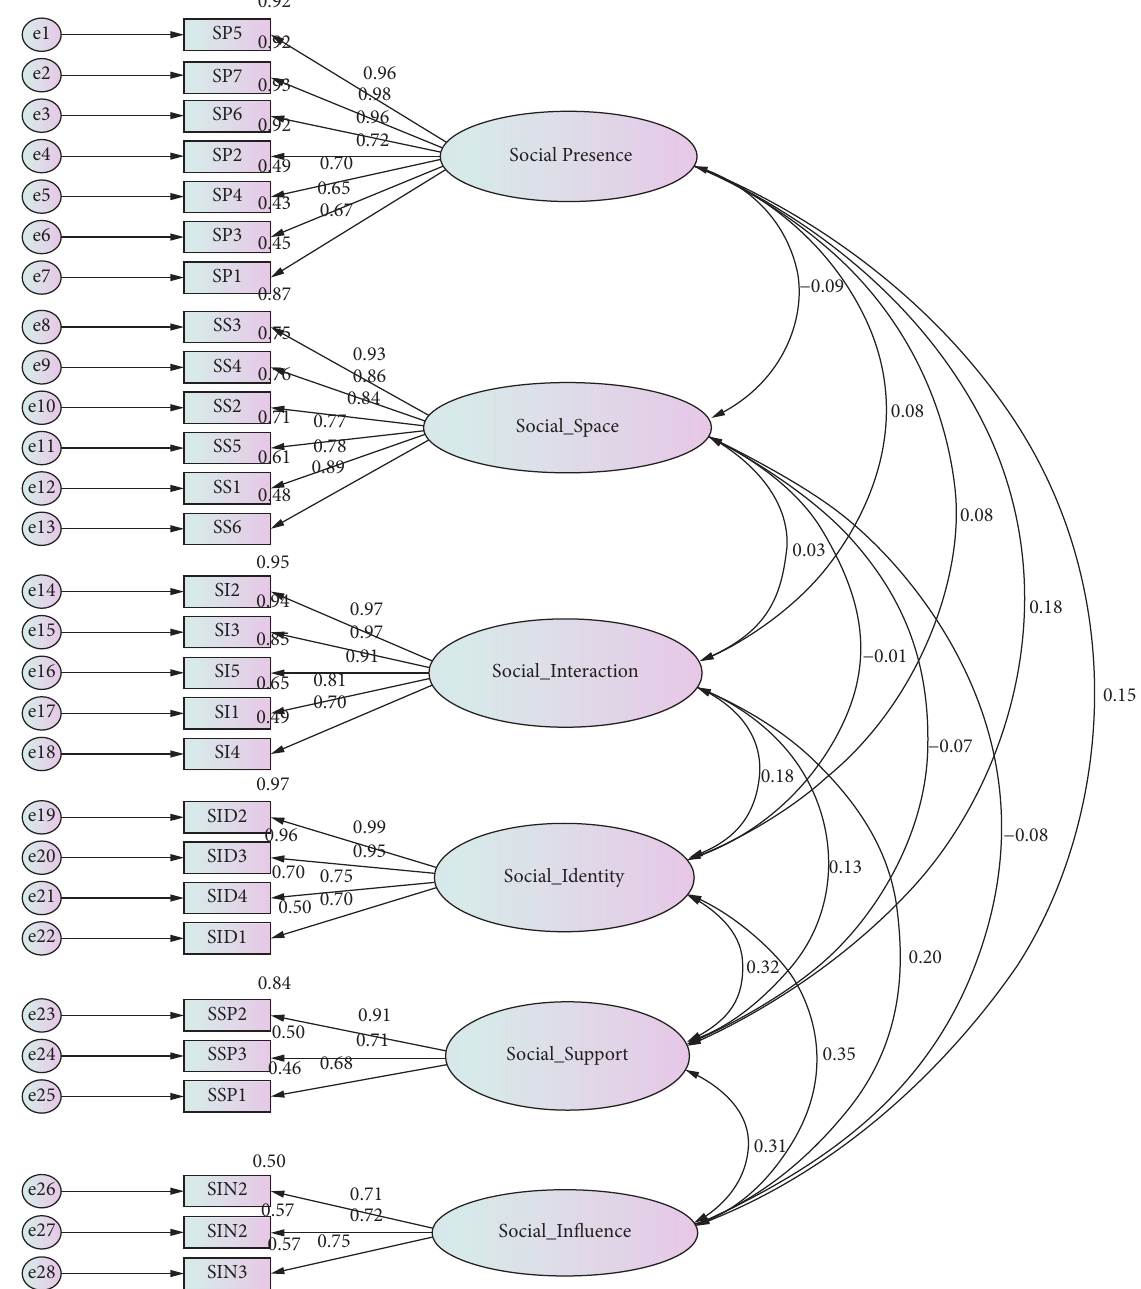
Figure 2: Confirmatory factor